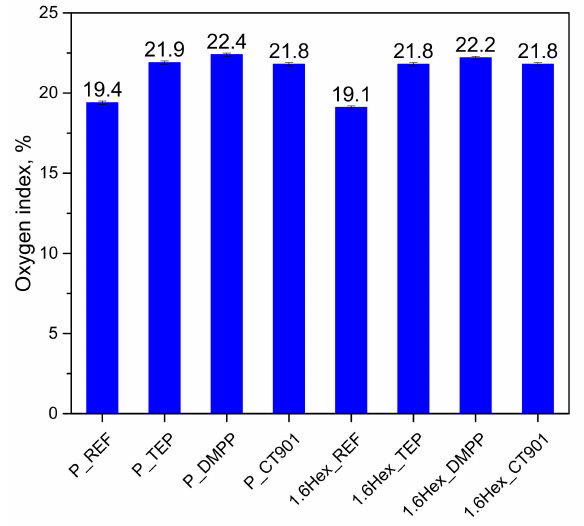
Figure 7. Changes in linear dimensions of RPURFs after seasoning at 70 ◦ C and 90% humidity for 24 h.